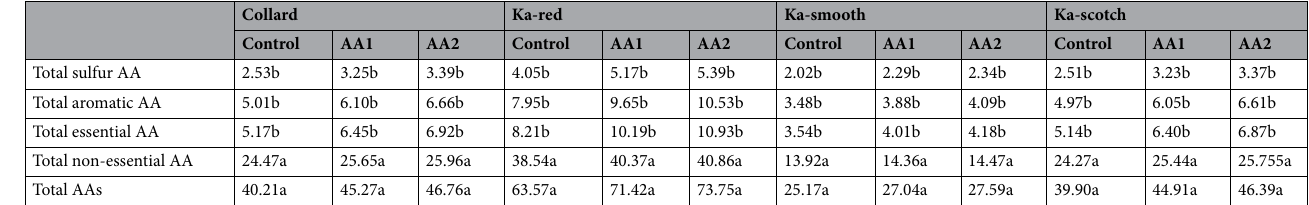
Table 7. Interaction effect of cabbage cultivar and AA application on different total AAs. Control control treatment, AA1 150 mg/L of amino acid, AA2 150 and 300 mg/L of amino acid. According to the least significant difference test, a row in each treatment and means followed by the same letter is not significantly different at P < 0.05.